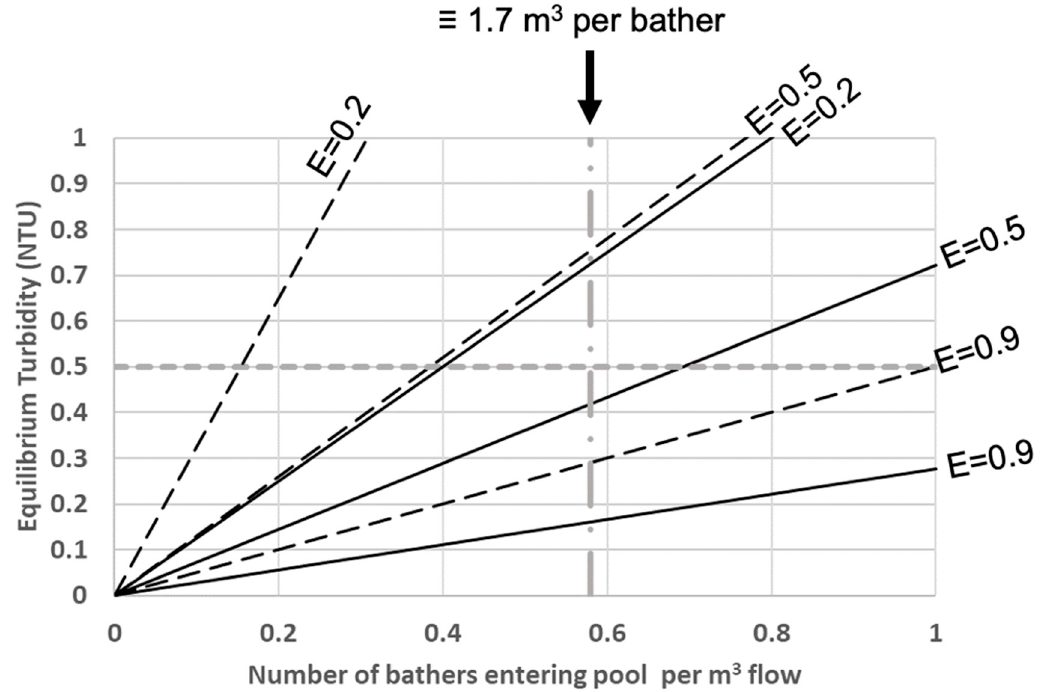
Figure 2. Effect of the number of bathers entering the pool per unit volume of water flow through the filtration system on pool water equilibrium turbidity (NTU), assuming different dirt loadings per bather (solid line K p = 0.25 NTU (bather m − 3 ) − 1 ; dashed line K p = 0.65 NTU (bather m − 3 ) − 1 ) and different filtration efficiencies (E). The x-axis is the ratio of the number of bathers entering the pool to the volume (m 3 ) of water flow through the filtration system (i.e., B/Q from Equation (12)) and value of 0.58 is equivalent to 1.7 m 3 water flow through the filtration system per bather.